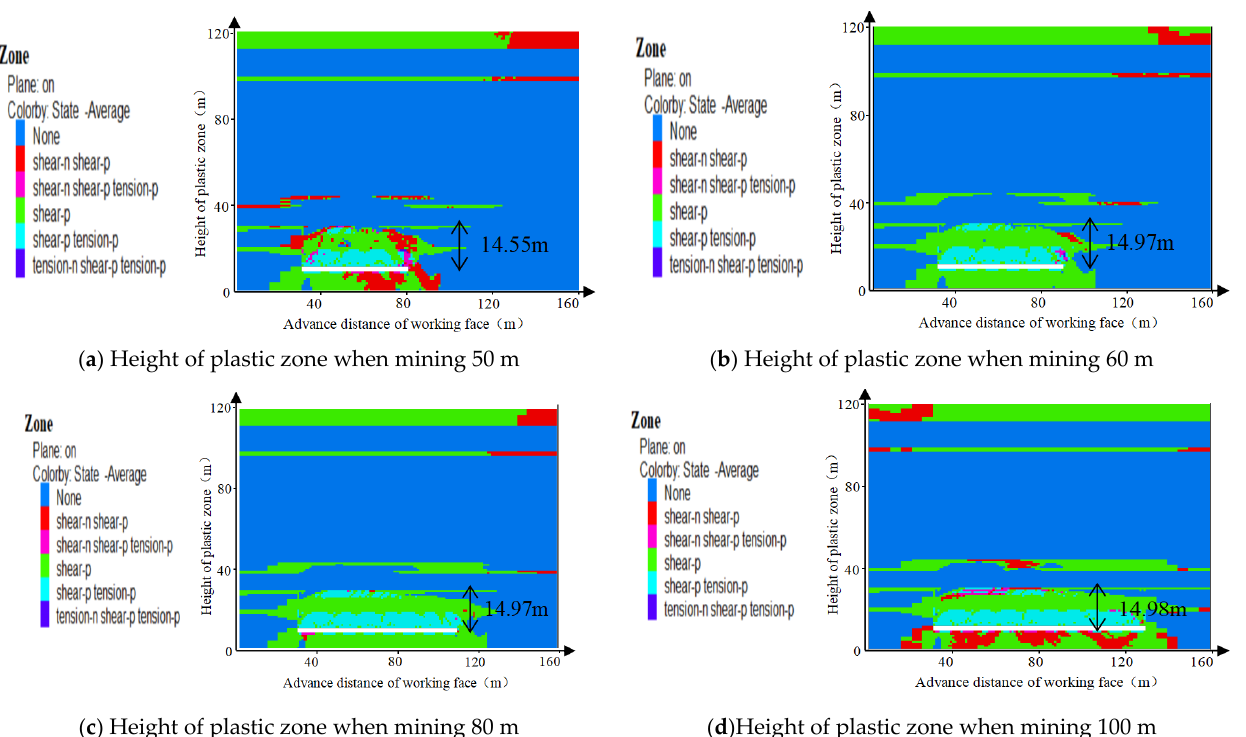
Figure 9. Distribution nephogram of vertical principal stress in goaf. 4. The distribution characteristics of the plastic zone of the surrounding rock in the goaf with different advance distances. Figure 10 shows the distribution nephogram of the plastic zone of the surrounding rock in the goaf with different advance distances.